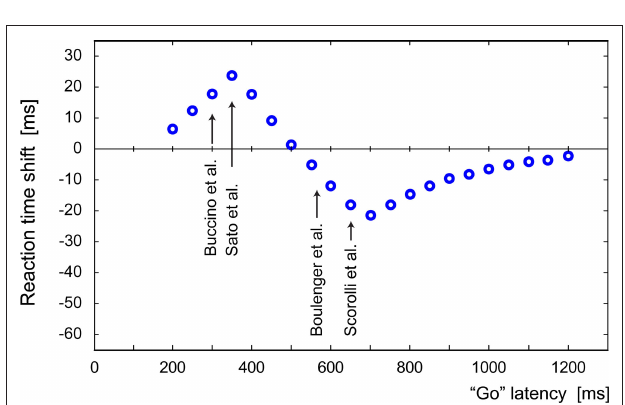
Figure 6 | Activation profile of the “reaching-pressing” chain after the presentation of the two sentences in the simulated task. The dashed vertical lines indicate the sentence presentation onset (left), the Go signal presentation (middle), and moment of maximal activity (right). In case of early “Go”